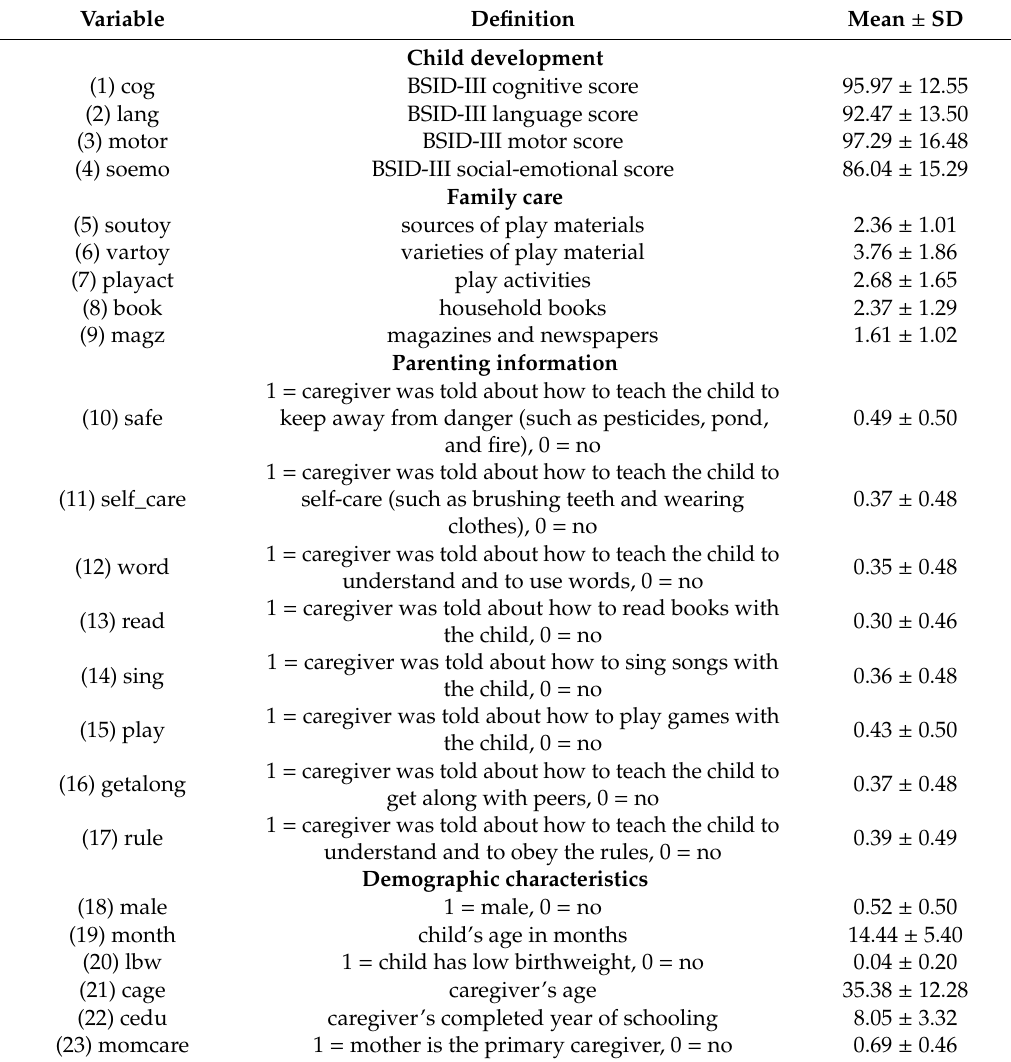
Table 1. Summary statistics ( N = 1787 for all